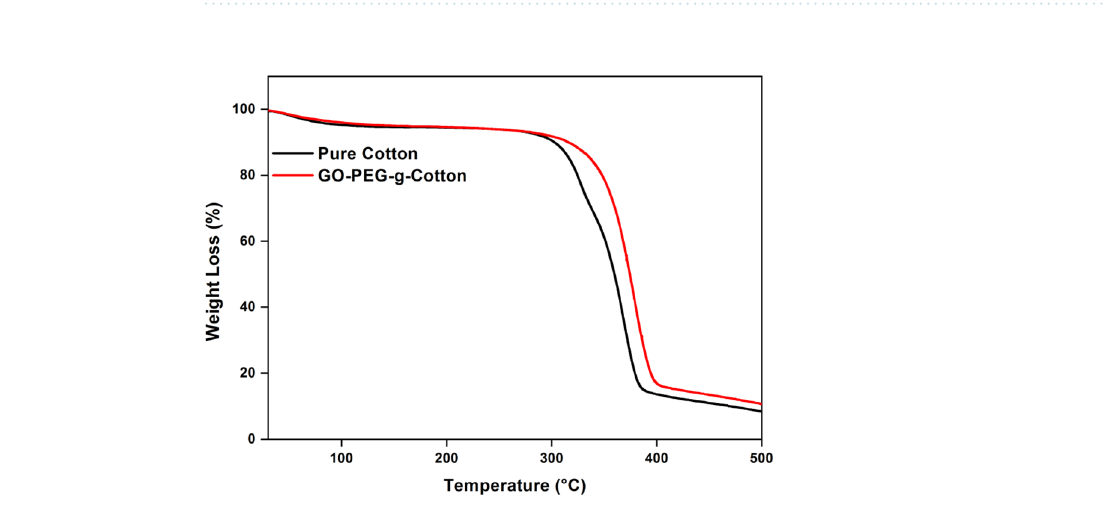
Table 1. Literature for incorporation of PCM into textile.